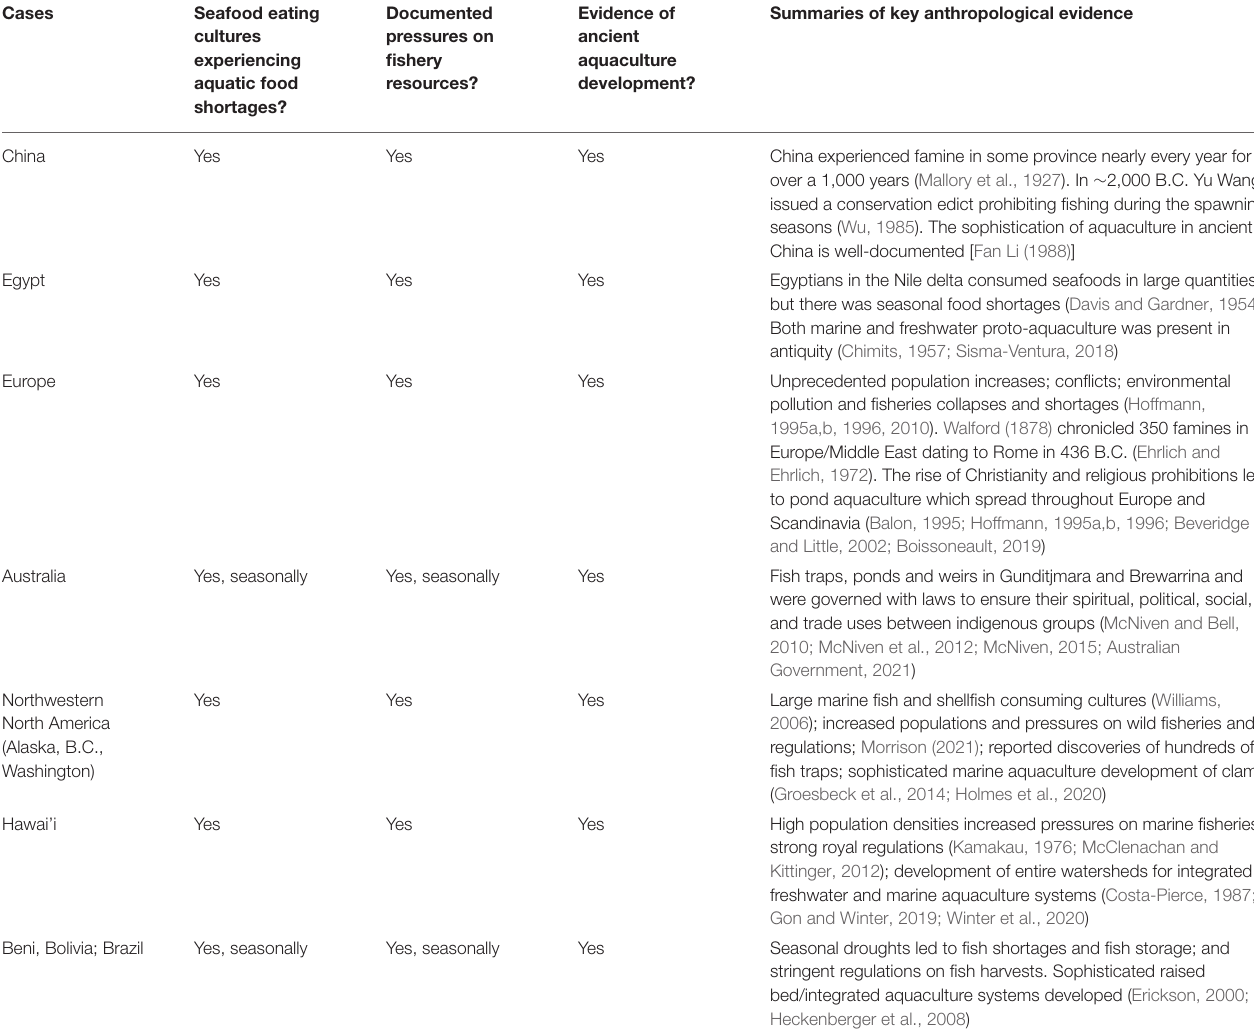
TABLE 2 | Evaluation of evidence of six historical case studies.